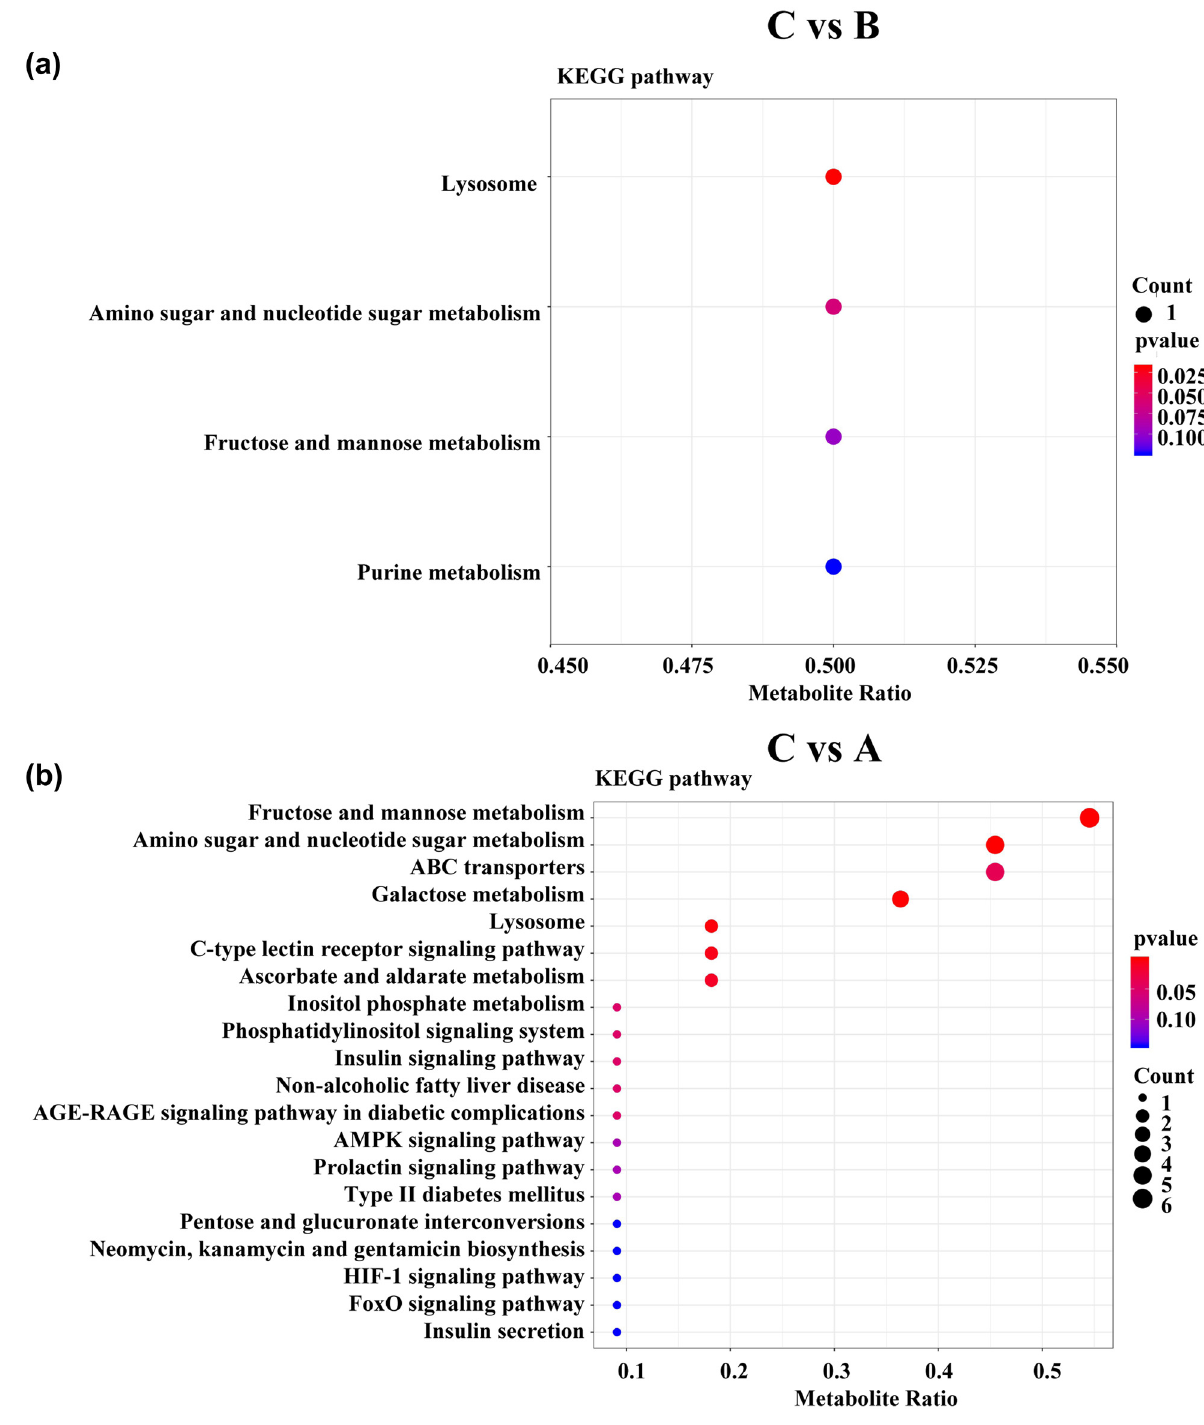
Figure 4: Analyses of metabolic pathways. ( a ) KEGG pathway analyses of the di ff erential metabolites in C vs B. ( b ) KEGG pathway analyses of the di ff erential metabolites in C vs A. Each point represents one metabolic pathway. The size of the dots indicates the number of metabolites. Circle colours indicate pathway enrichment signi fi